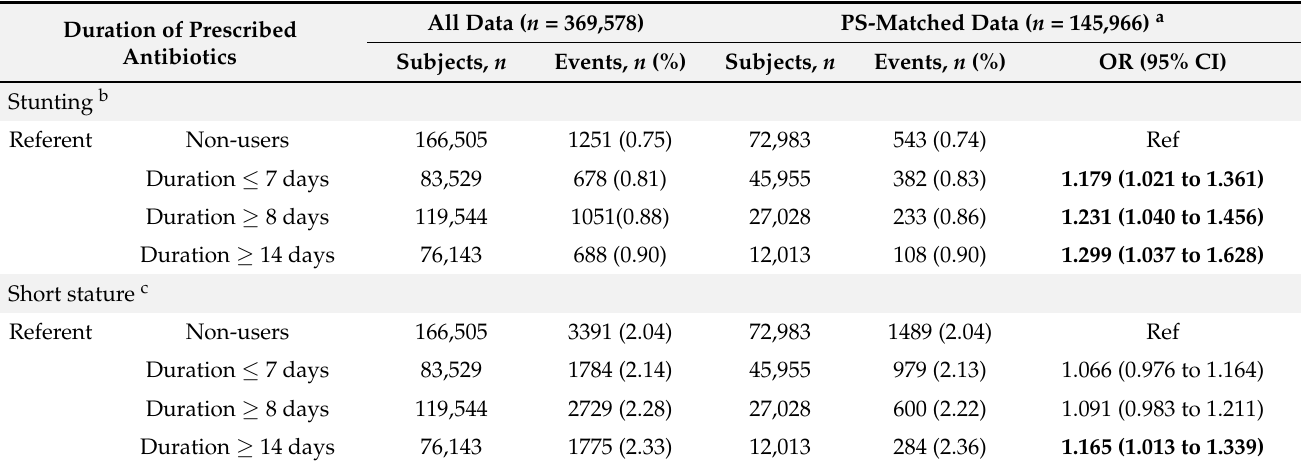
Table 4. The duration-dependent effect of antibiotic use on stunting and short stature in children. All Data ( n = 369,578)